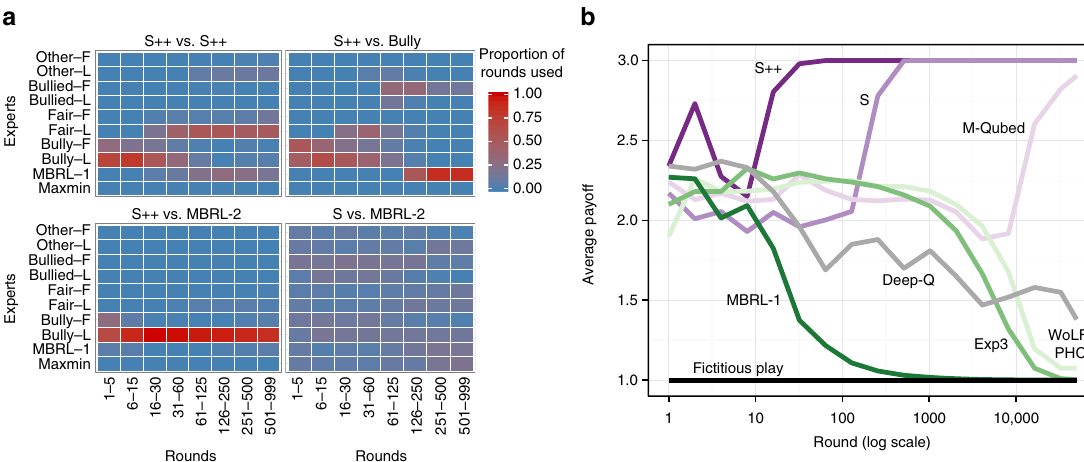
Fig. 1 Illustrations of S++ ’ s learning dynamics. a An illustration of S++ ’ s learning dynamics in Chicken, averaged over 50 trials. For ease of exposition, S++ ’ s experts are categorized into groups (see Supplementary Note 3 for details). Top-left: When (unknowingly) paired with another agent that uses S++, S++ initially tries to bully its partner, but then switches to fair, cooperative experts when attempts to exploit its partner are unsuccessful. Top-right: When paired with Bully, S++ learns the best response, which is to be bullied, achieved by playing experts MBRL-1, Bully-L, or Bully-F. Bottom-left: S++ quickly learns to play experts that bully MBRL-2, meaning that it receives higher payoffs than MBRL-2. Bottom-right: on the other hand, algorithm S does not learn to consistently bully MBRL-2, showing that S++ ’ s pruning rule (see Eq. 1 in Methods) enables it to teach MBRL-2 to accept being bullied, thus producing high payoffs for S++. b The average per-round payoffs (averaged over 50 trials) of various machine-learning algorithms over time in self-play in a traditional (0-1-3-5)-prisoner ’ s dilemma in which mutual cooperation produces a payoff of 3 and mutual defection produces a payoff of 1. Of the machine- learning algorithms we evaluated, only S++ quickly forms successful relationships with other algorithms across the set of 2 × 2